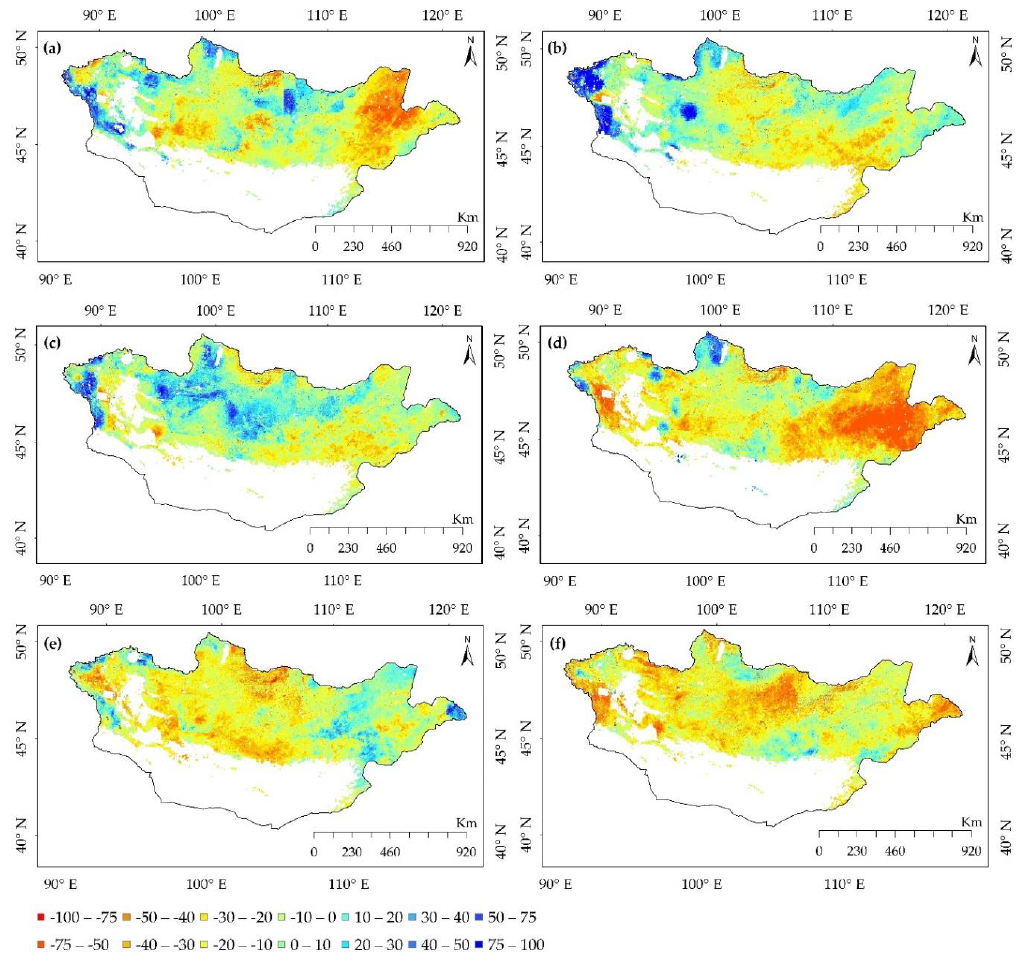
Figure 6. The spatial pattern of percentage change in NPP across Mongolia during periods experiencing the most drought: ( a ) May–September 2004, ( b ) May–September 2005, ( c ) May–September 2006, ( d ) May–September 2007, ( e ) May–September 2009, and ( f ) May–September 2017. The percentage change refer to the NPP variation during drought events relative to the long-term average growing seasonal value of NPP corresponding to the period. The negative/positive value represents the decrease/increase in NPP during the drought events.